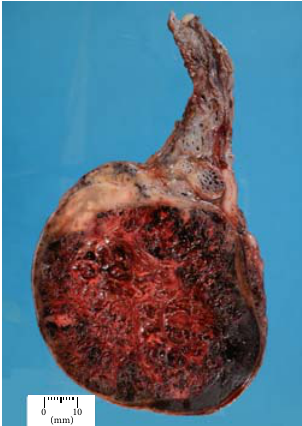
Figure 1: Gross image of the resected testis demonstrating replace- ment of the parenchyma by a diffusely haemorrhagic, centrally necrotic tumour.